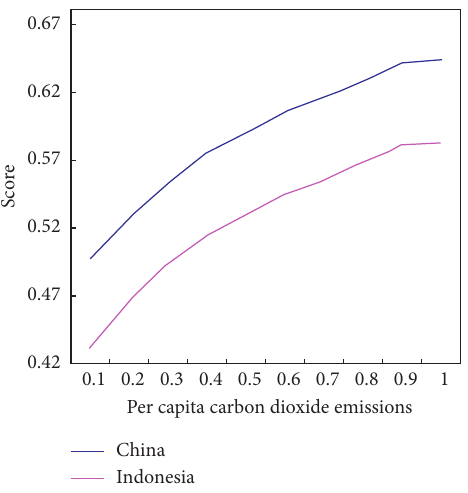
Figure 7: Score of vulnerable countries.